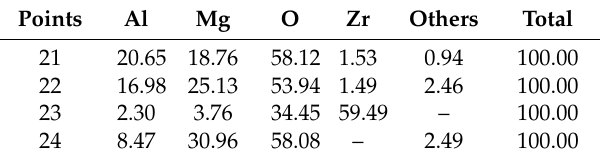
Figure 11. Corrosion morphologies of the Al/Zr/Mg joint in the 3.5% NaCl solution for 60 h: ( a ) overview and ( b – d ) magnified views of the R16, R17, and R18, respectively. Table 8. Elemental compositions (in wt.%) of points 21–24 in Figure 11b–d.